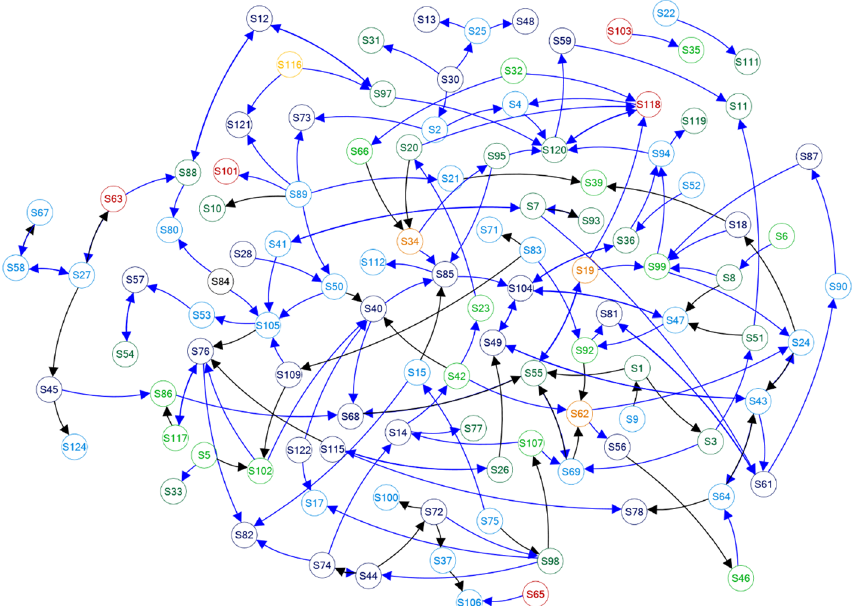
Fig. 3 Social graph of the academic community. Blue edges represent messages of gratitude, with the node colour representing countries about which students have submitted reports. The node labels are identifiers of students